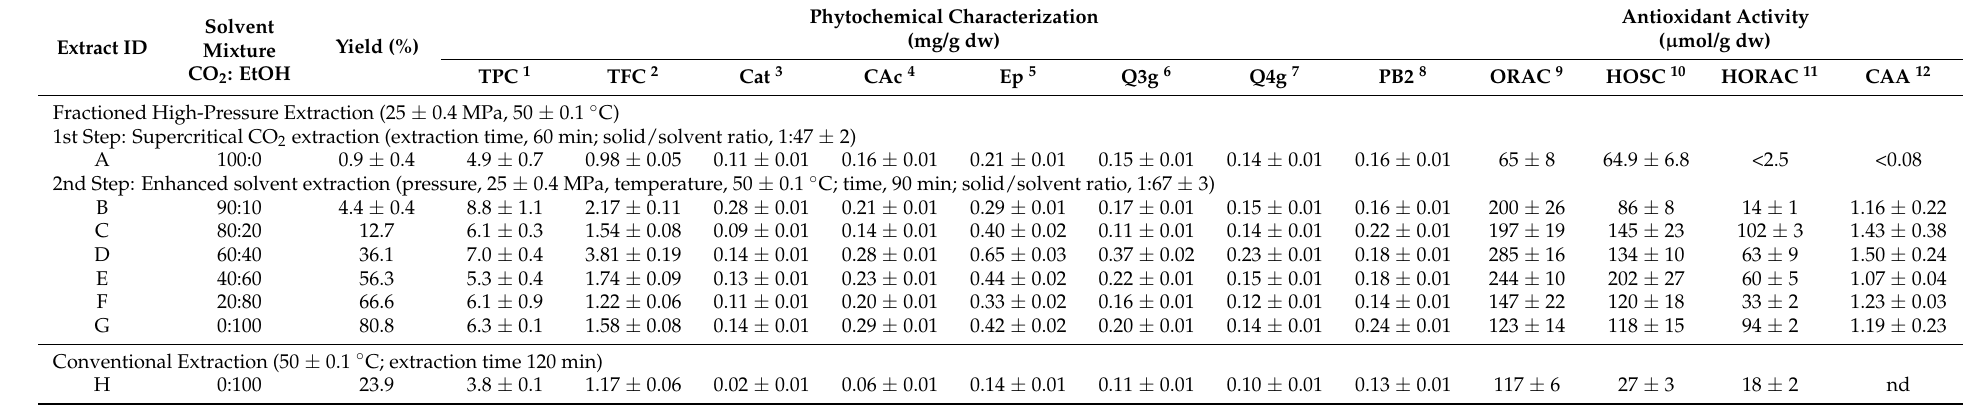
Table 1. Bravo de Esmolfe extracts obtained using high-pressure technology and conventional solid–liquid ethanol extraction; experimental conditions, global yields, phenolic contents and antioxidant activities were estimated for each